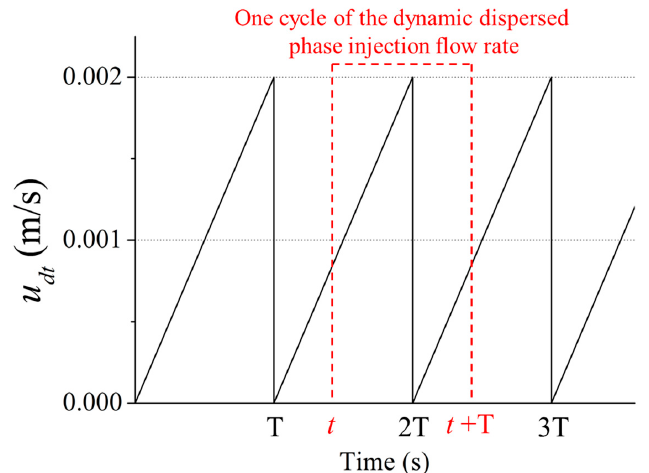
Figure 9. Integration of a triangle wave dynamic phase injection flow rate during one cycle.